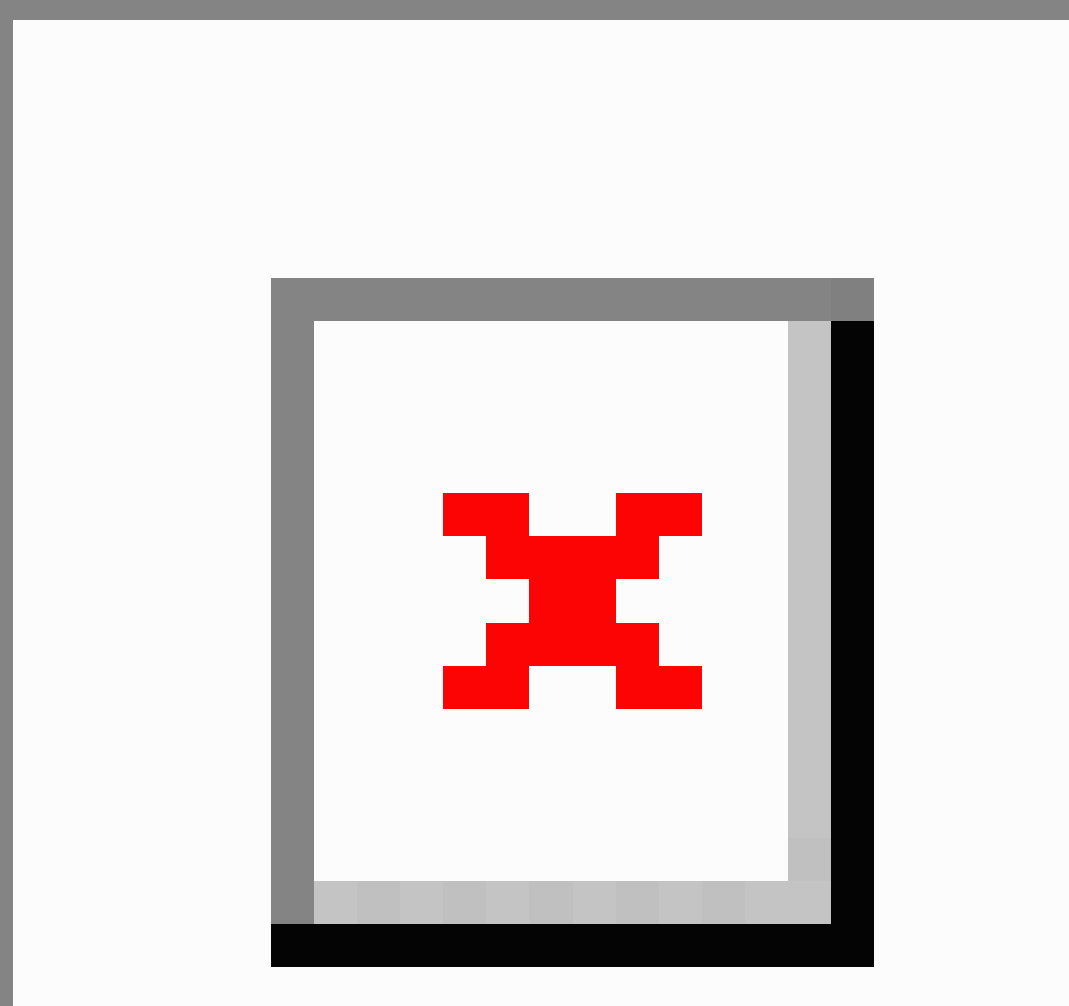
Figure 4. Mean nocturnal peripheral blood oxygen saturation (SpO 2 ) compared to mean daytime SpO 2 in rest. The dots indicate weekly averages of mean SpO 2 for every patient, lines indicate the standard deviation of the mean SpO 2 values over different days and nights, and the orange line is the line of